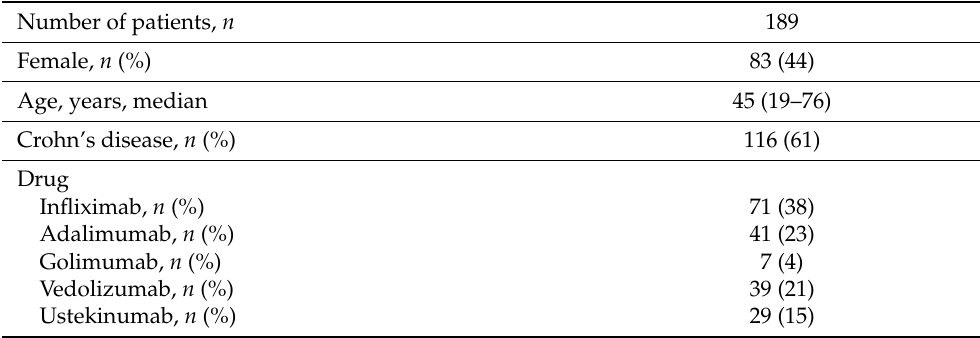
Table 1. Patients’